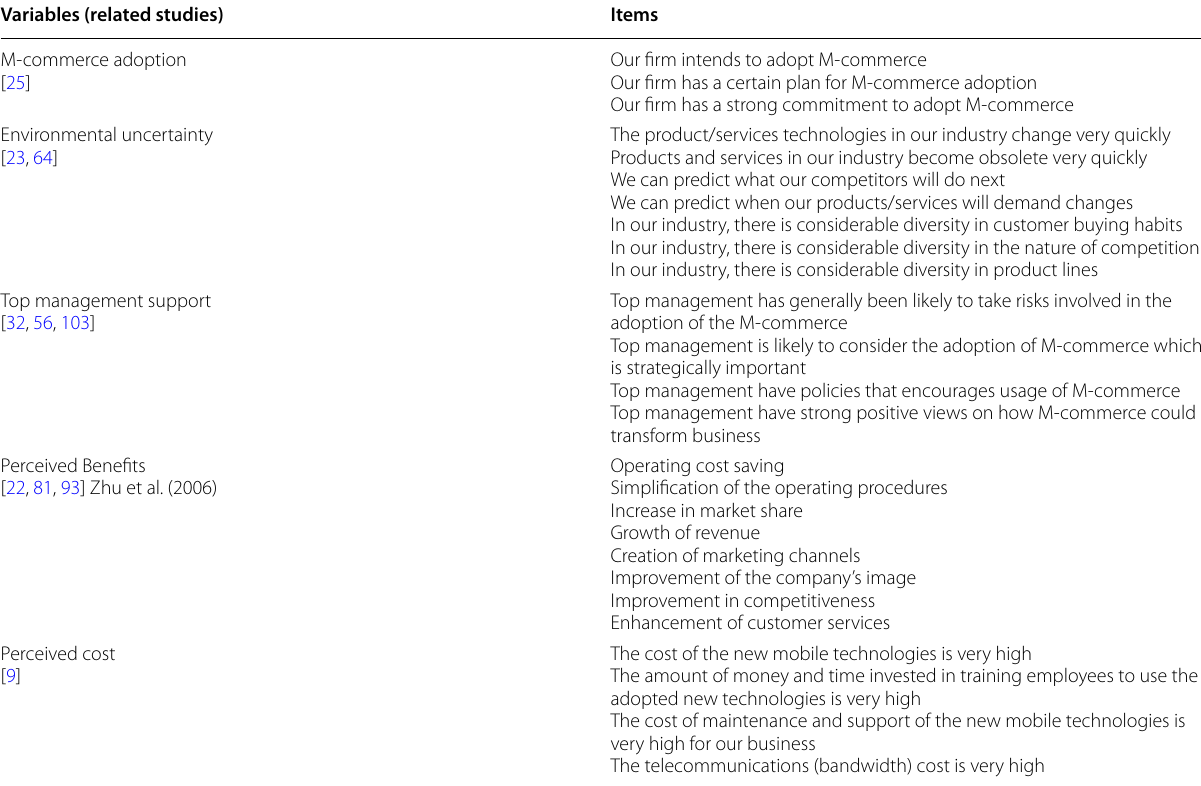
Table 1 Variables, Items and Related studies Variables (related studies)